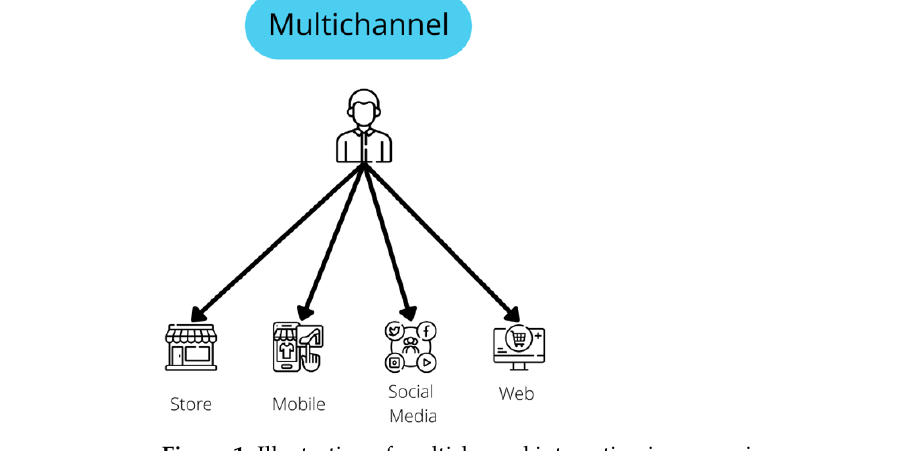
Figure 1. Illustration of multichannel interaction in a generic use case.